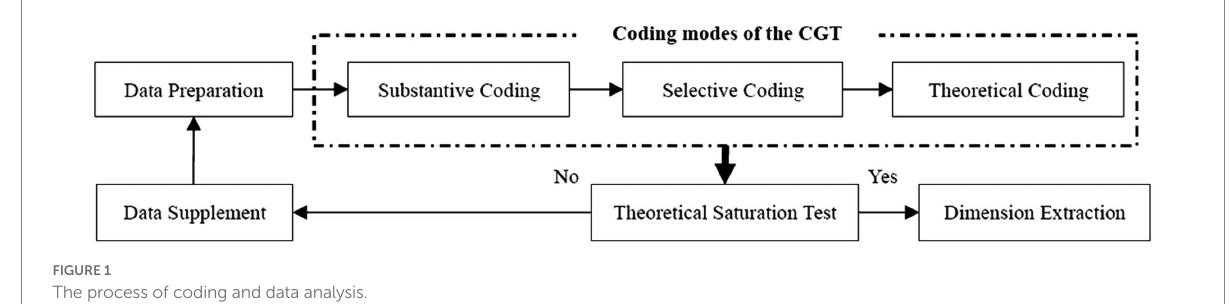
FIGURE 1 The process of coding and data